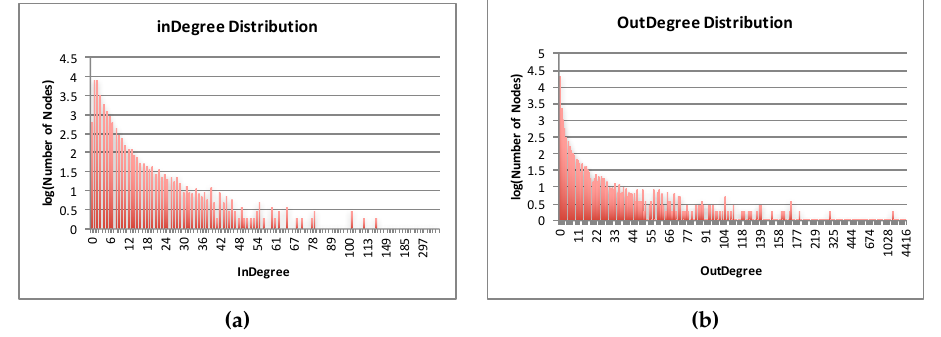
Figure 1. Histograms of Indegree and Outdegree of the Nodes of the Internet Graph from DIMES at the Level of Autonomous Systems ( AS ). The bar graphs show (the logarithm, base 10, of) the number nodes with a particular outdegree ( a ) and indegree ( b ) value. (The graphs only show the in/out degrees with a non-zero number of nodes.)